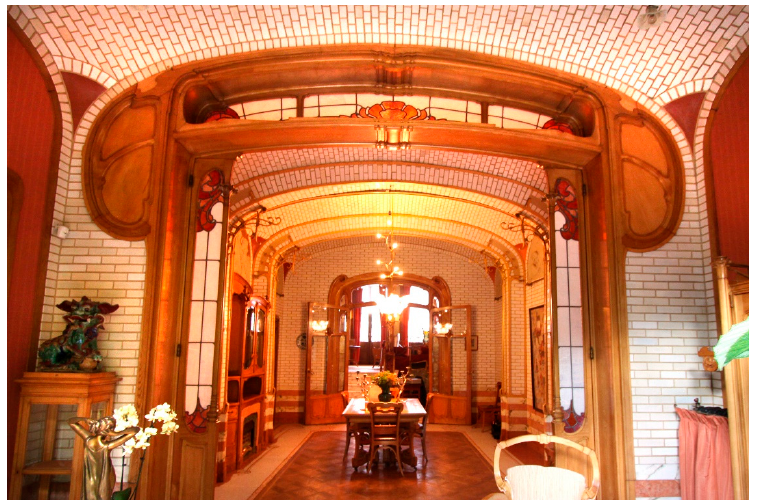
Figure 4 . The bright interiors of the Horta House. Figure 4. The bright interiors of the Horta House. Arts 2021 , 10 , x FOR PEER REVIEW